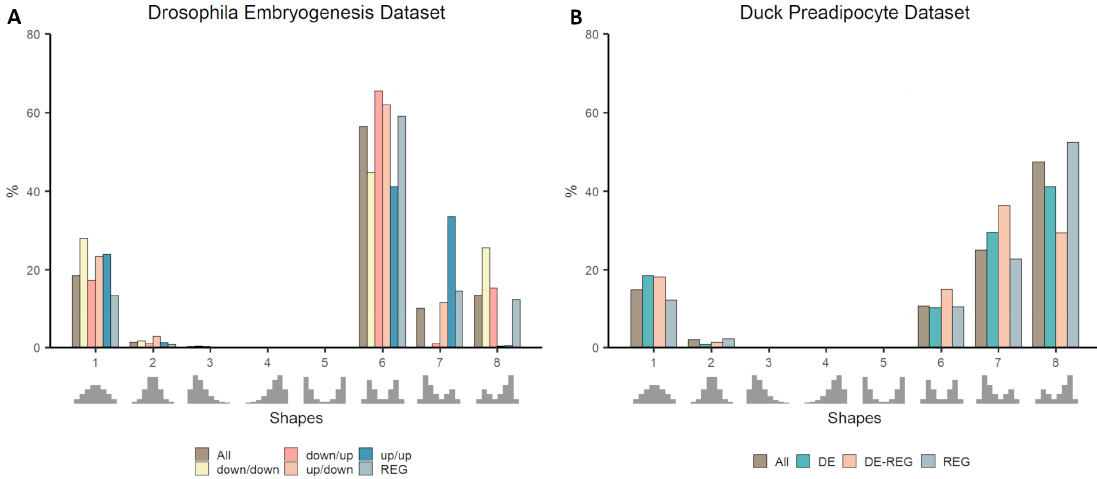
Figure 4. Proportion of genes falling in each template shape in time-series datasets: Drosophila embryogenesis ( A ) and Duck Preadipocyte ( B ). The proportion of genes classified as DE, REG, or DE-REG are compared to the overall (All) proportion of genes within each shape. In the Drosophila dataset, DE genes were clustered into four groups (down/down, down/up, up/down, and up/up); refer to methods for more information.